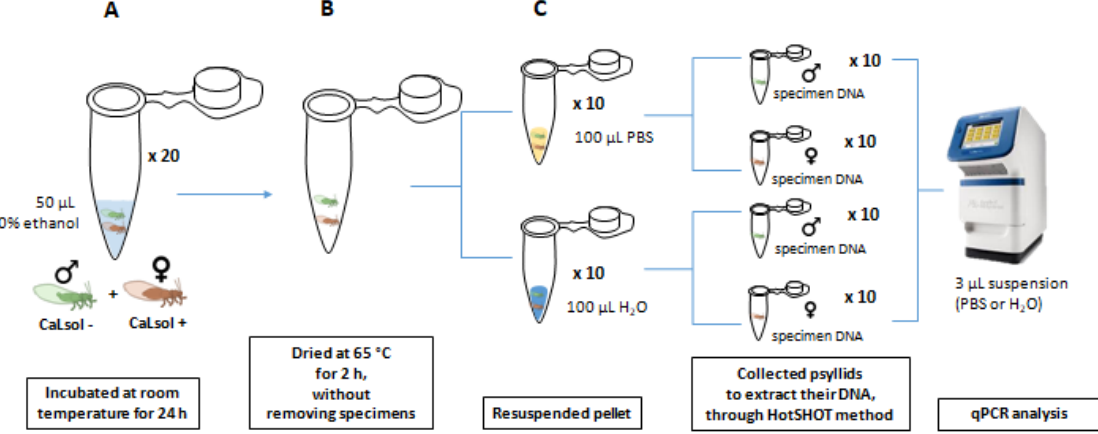
Figure 3. Cross-contamination study: Assay 3. Samples containing a pair of psyllids [one CaLsol-positive female ( ♀) and one CaLsol-free male ( ♂) ] were incubated in ethanol ( A ). The ethanol was dried without removing the specimens ( B ). The samples were resuspended in water or PBS ( C ) and the psyllids were individually separated in different tubes before DNA extraction by the HotSHOT method.